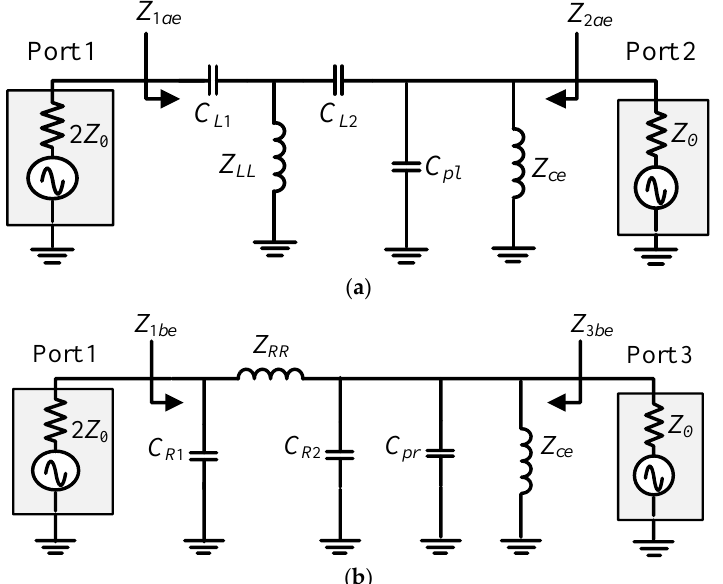
Figure 8. The even-mode circuits of balun with the common inductor between ( a ) Port 1 and Port 2 and ( b ) Port 1 and Port 3.